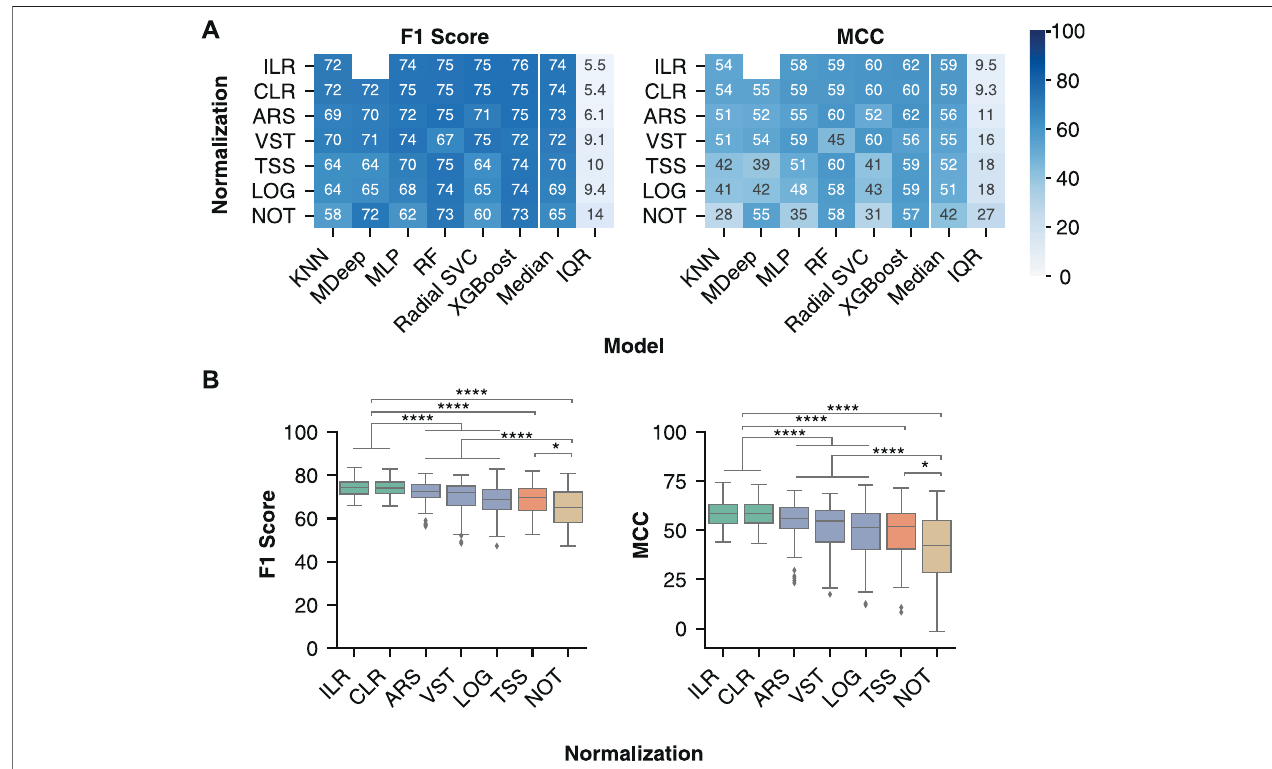
FIGURE 4 | Compositional transformation methods lead to the highest model performance for IBD classi fi cation. (A) Median model performance with each normalization or transformation method across all batch effect correction methods. (B) Distribution of classi fi cation performance of different classes of normalization methods. The compositional category consists of CLR and ILR (green), variance/distribution modi fi ers consist of VST, ARS, and LOG(blue), scaling consists of TSS (orange),andnonormalizationconsistsofNOT(brown).Classi fi cationperformancefollowingdataprocessingwithallpairwisecombinationsofthenormalizationor transformation methods (ILR, CLR, LOG, ARS, VST, TSS and NOT) and batch effect correction methods (No batch effect correction, MMUPHin #1, MMUPHin #2, ComBat-seq #1, ComBat-seq #2, and Zero-Centering) were included. Rows were sorted in descending order by the median of each performance metric across the non-linear models. No analysis was performed for MDeep paired with ILR as the ILR normalized values no longer map directly to a feature, therefore removing the phylogenetic structure required for MDeep. **** indicates p -value < 0.0001 and * indicates p -value < 0.05.